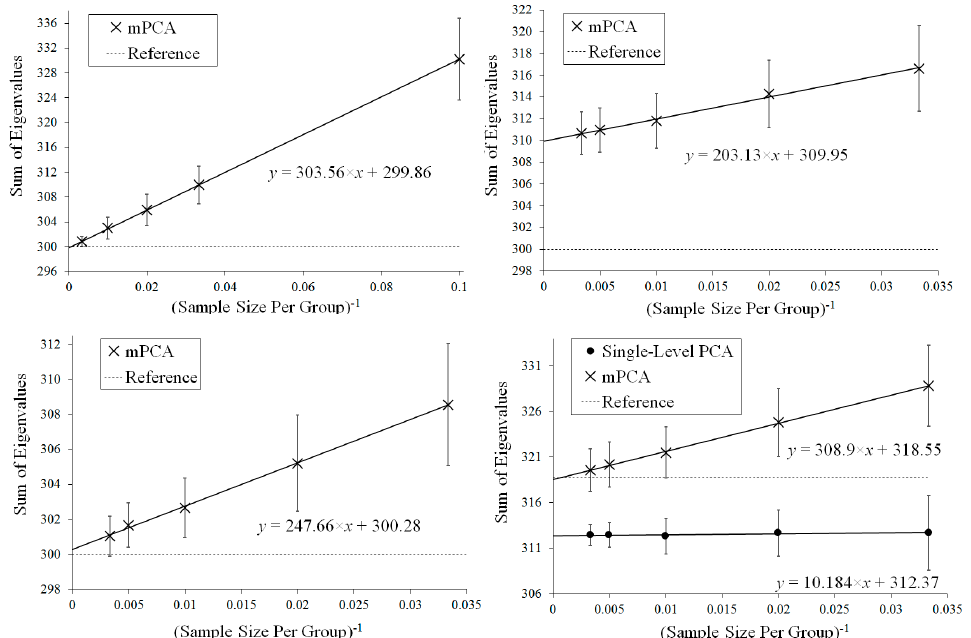
Figure 4. Extrapolation of the mean (over all MC simulations) sum of all eigenvalues for mPCA in the limit sample size per group 𝑛 (cid:3039) → ∞ for Experiment 1 ( top left ), Experiment 2a ( top right ), Experiment 2b ( bottom left ), and Experiment 3 ( bottom right ). These values via mPCA scale approx- imately linearly with 𝑛 (cid:3039)(cid:2879)(cid:2869) . Reference values for the asymptotic estimates of the total variance are shown by the dashed lines in these figures (equal to 300 for Experiments 1 and 2 and to 318.75 for Experiment 3). Results of single-level PCA for Experiment 3 are approximately “flat” with respect to 𝑛 (cid:3039)(cid:2879)(cid:2869) . (Standard errors are shown by the error bars.)